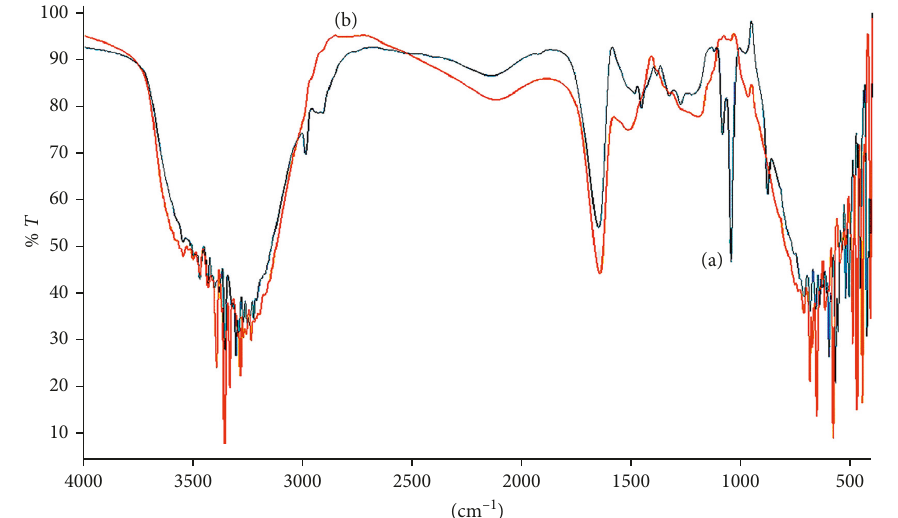
Figure 4: FTIR spectra of (a) the mortiño berry extract and (b) as-prepared multicomponent